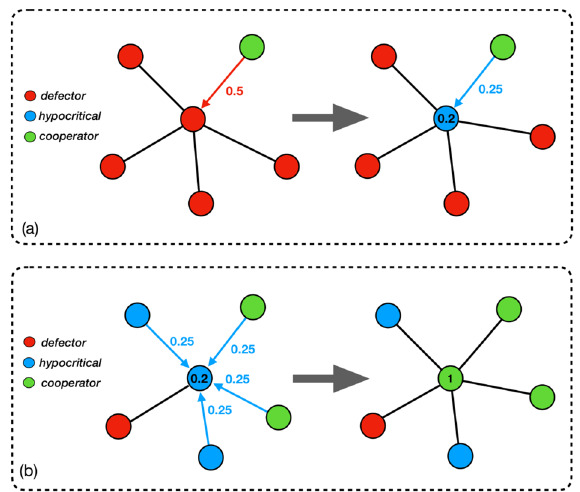
Figure 1. The two stages of the dynamics. The direction of the red and blue arrows indicates the direction of the social-pressure applied on the player occupying the central vertex. Cooperative players pay an energetic cost of E c = 1 and are immune to social-pressure. A defector player pays a social-pressure cost of ρ d = 0.5 per non- defector neighbor. A hypocritical player pays social-pressure cost of ρ h = 0.25 per non-defector neighbor, and an energetic cost of E h = 0.2 . ( a ) First stage: defectors become hypocritical players. A defector player (central vertex on the left) has one non-defector neighbor (in this case, a cooperator), implying that its social-pressure cost is ρ d = 0.5 . Therefore, that player would prefer to be hypocritical (right), paying only 0.25 + 0.2 = 0.45 . ( b ) Second stage: hypocritical players become cooperators. Here, a hypocritical player (central vertex on the left) is surrounded by four non-defector neighbors. In this case, the social-pressure accumulates to favor cooperation